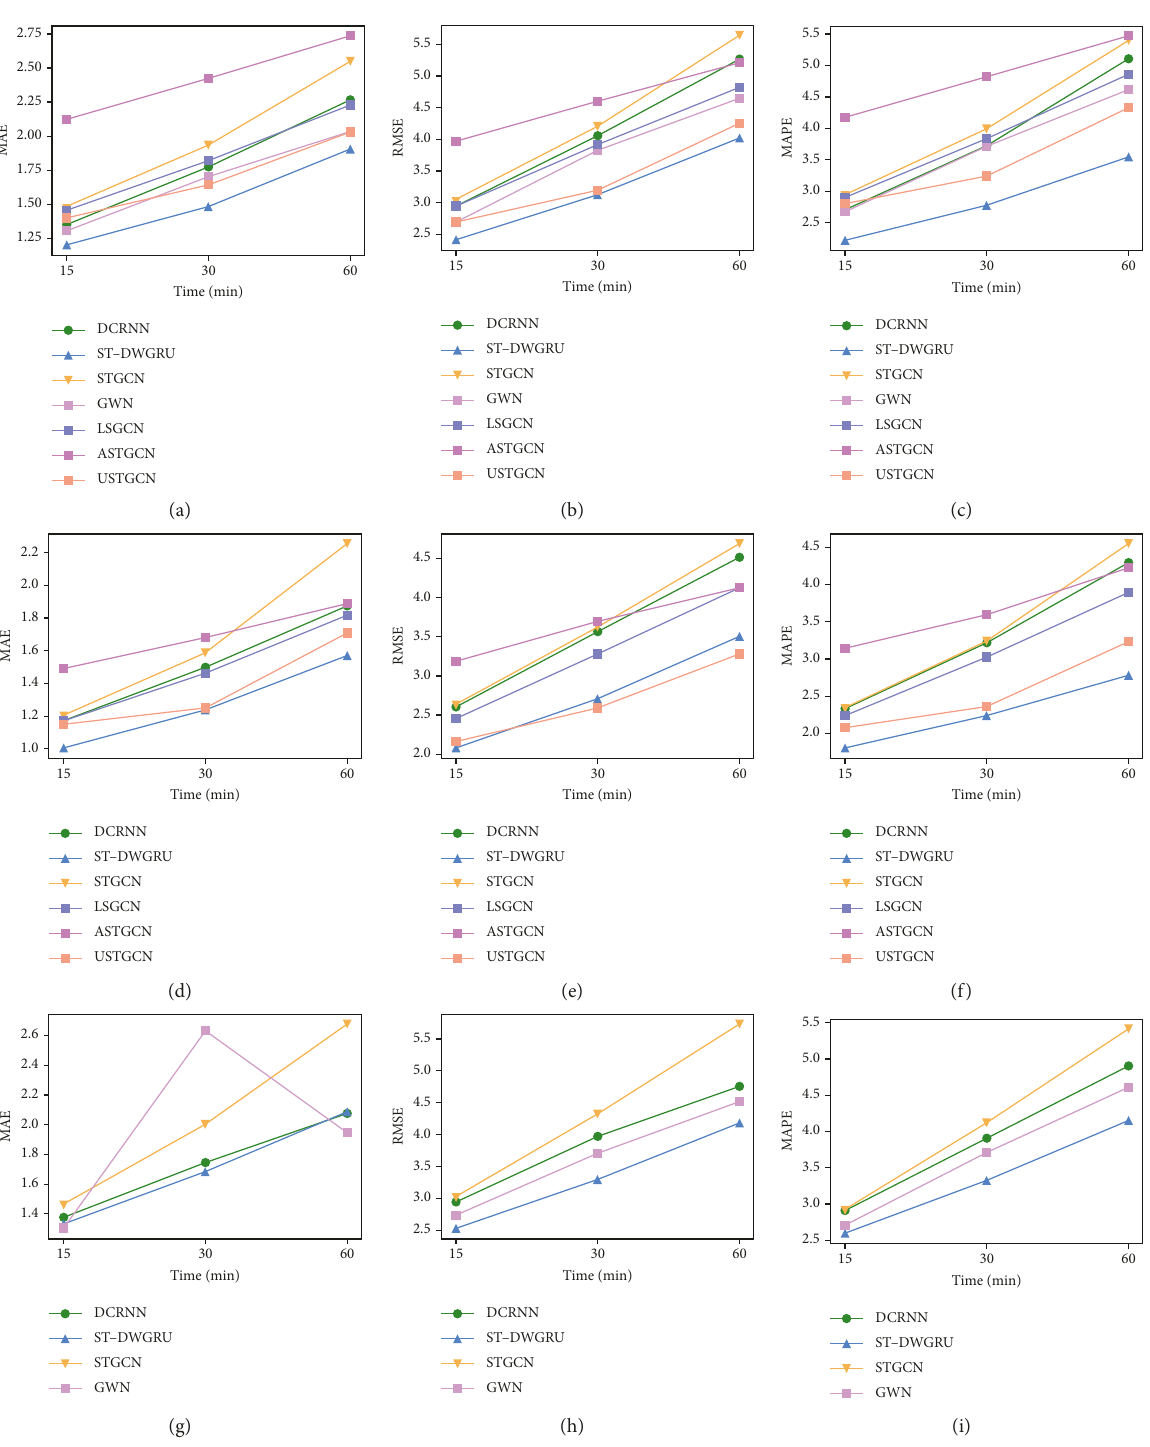
Figure 4: Trends in MAE and RMSE on PeMSD4, PeMSD8, and PeMS-BAY. (a) MAE of PeMSD4. (b) RMSE of PeMSD4. (c) MAPE of PeMSD4. (d) MAE of PeMSD8. (e) RMSE of PeMSD8. (f) MAPE of PeMSD8. (g) MAE of PeMS-BAY. (h) RMSE of PeMS-BAY. (i) MAPE of